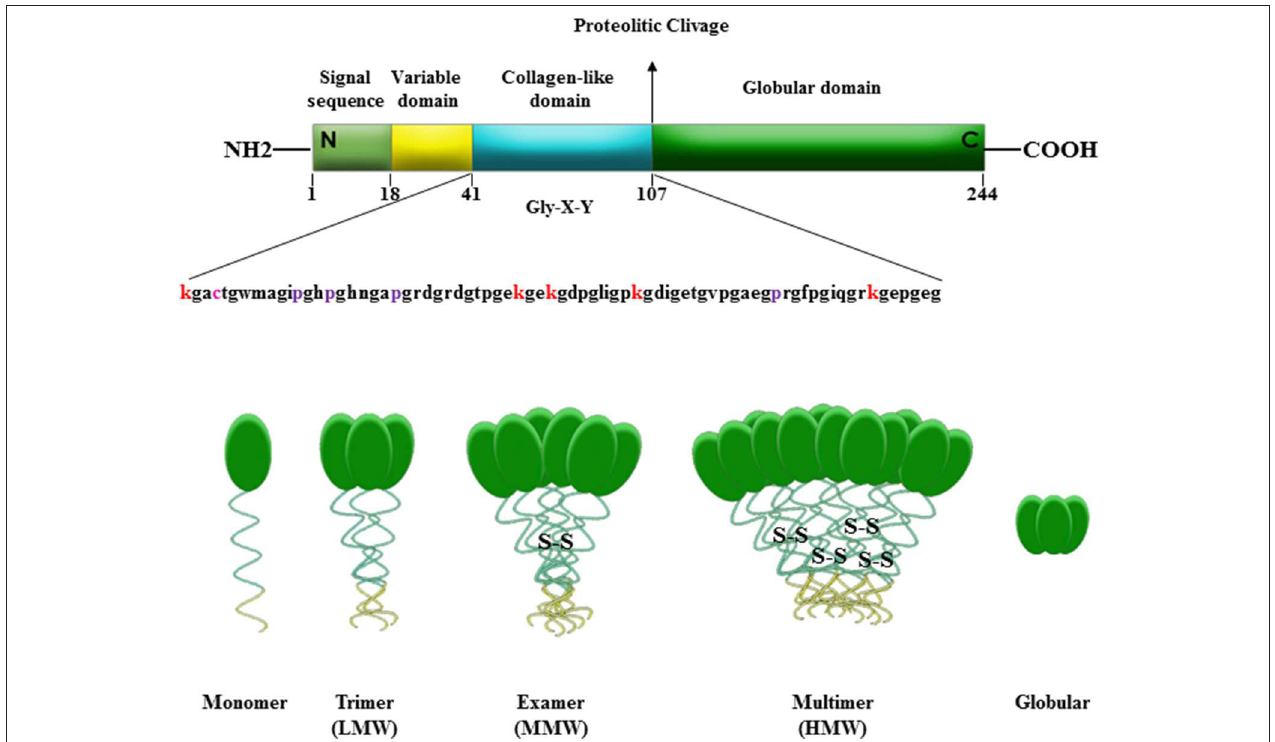
FIGURE 1 | Domains and molecular structure of adiponectin. Adiponectin is a 244 amino acid protein mainly synthetized by adipocytes as a single subunit including a N-terminal signal sequence, a variable region, a collagen-like domain and a globular domain in C-terminus. Adiponectin before secretion undergoes to oligomerization to form trimers (LMW), hexamers (MMW), and multimers (HMW). Adiponectin is also present in plasma in a globular isoform (gAd) generated by a proteolytic cleavage at amino acid 110 of the full-length protein